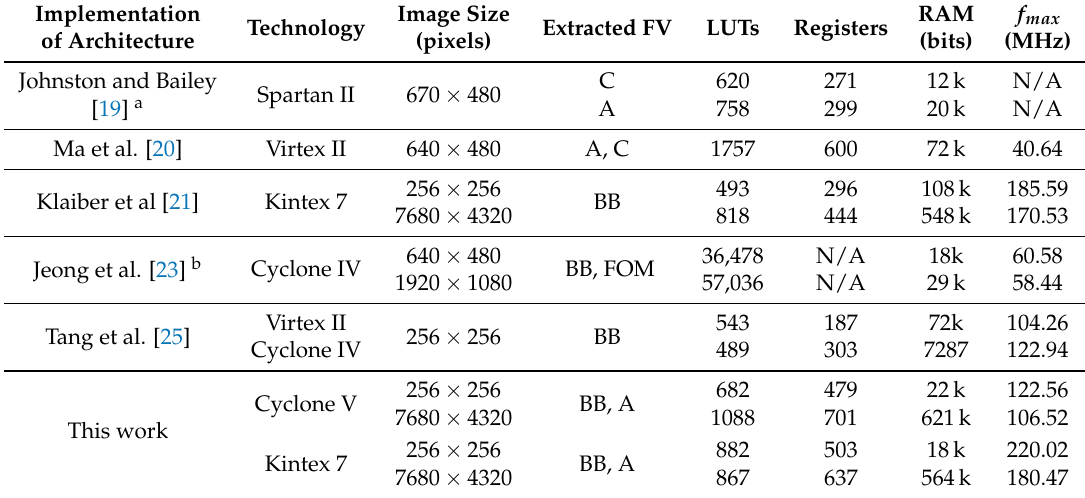
Table 4. Comparison of several CCA hardware architectures. Abbreviations for the extracted